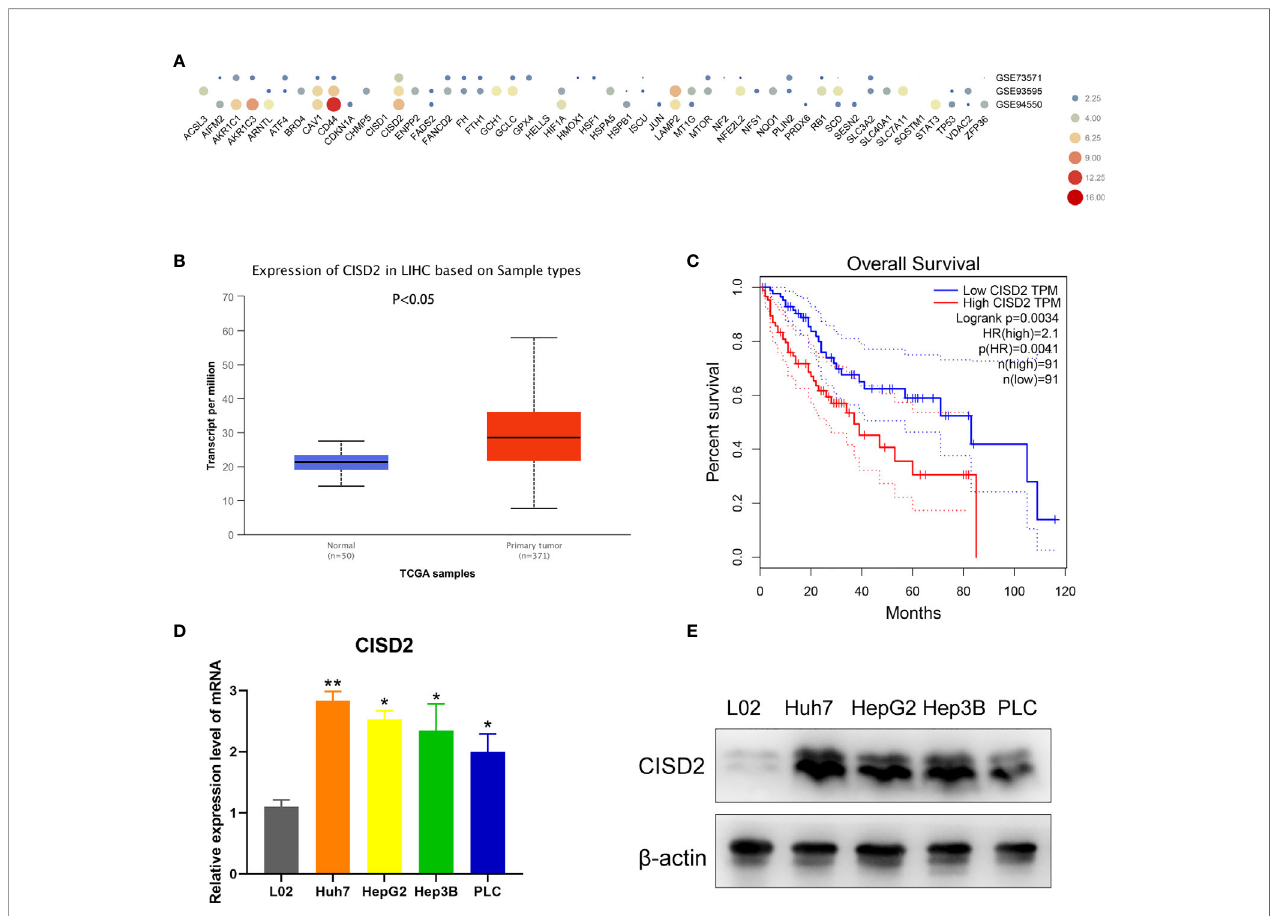
FIGURE 1 | CISD2 is upregulated in HCC cell lines and related to poor prognosis. (A) Bioinformatics was used to detect the expression level of ferroptosis genes in gene expression omnibus (GEO) database from GSE73571, GSE93595, GSE94550. (B) TCGA database was used to analyze the HCC RNA-seq data of 371 tumor tissues against 50 adjacent normal tissues. (C) GEPIA database was used to detect the Kaplan-Meier survival analysis. (D, E) qPCR and western blot were used to detect the expression level of normal hepatic epithelial cell (L02) and HCC cell lines (Huh7, HepG2, Hep3B, PLC) (n=3, * P < 0.05, ** P < 0.01 versus